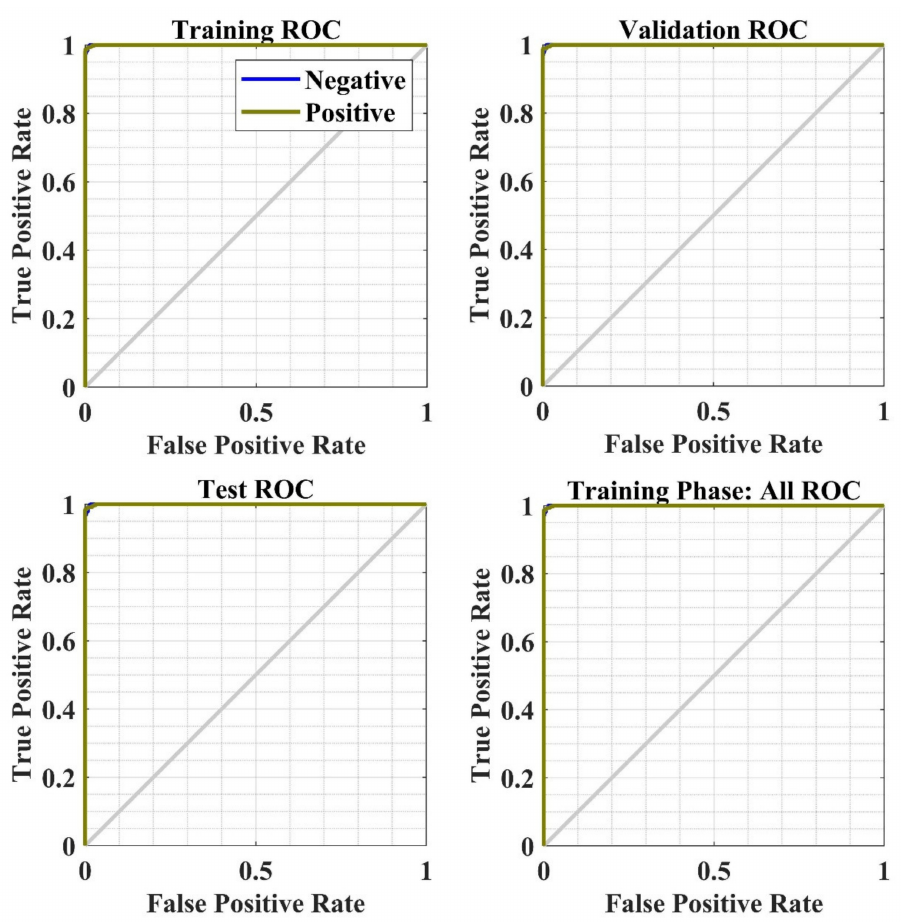
Figure 24. NN’s ROC curve w.r.t. the false-positive rate and true-positive rate for the training